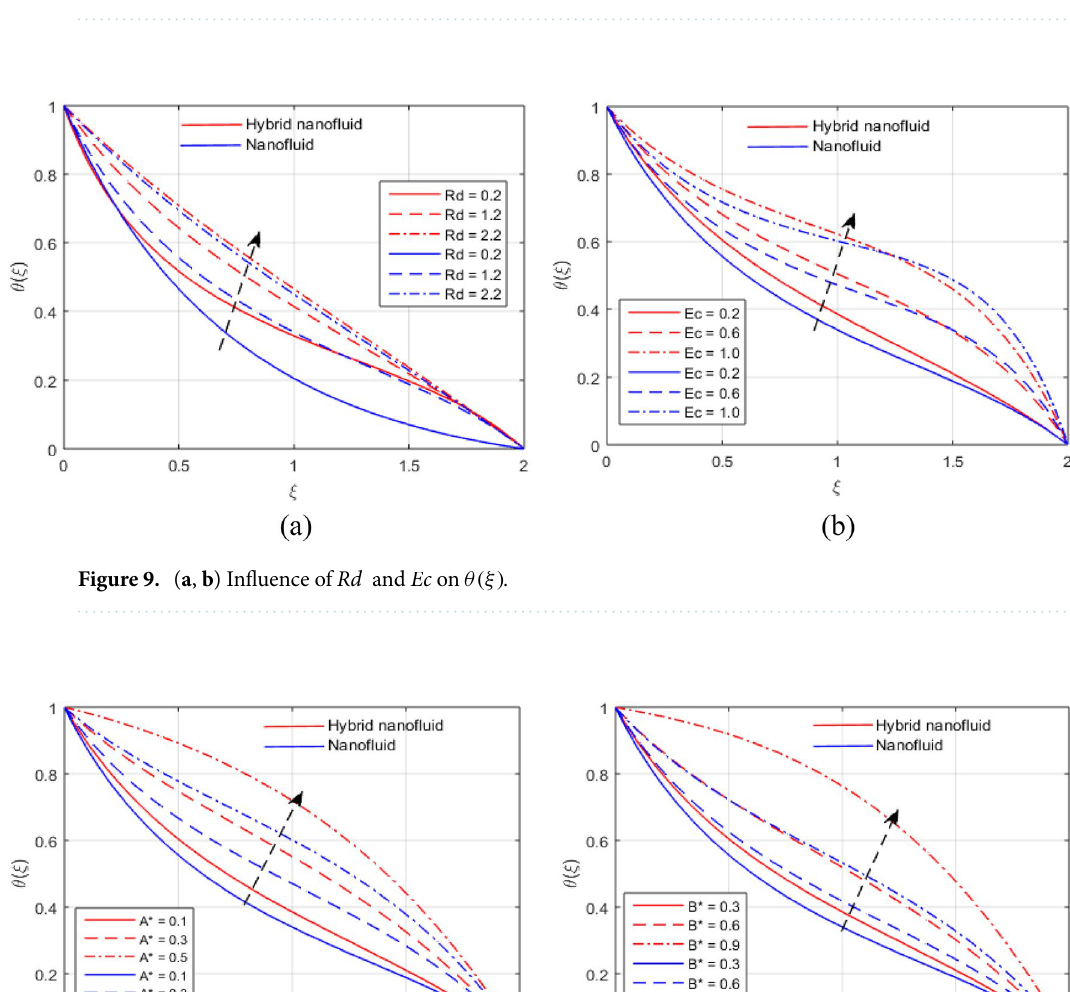
Figure 8. ( a , b ) Effect of F r and K on F (ξ) .